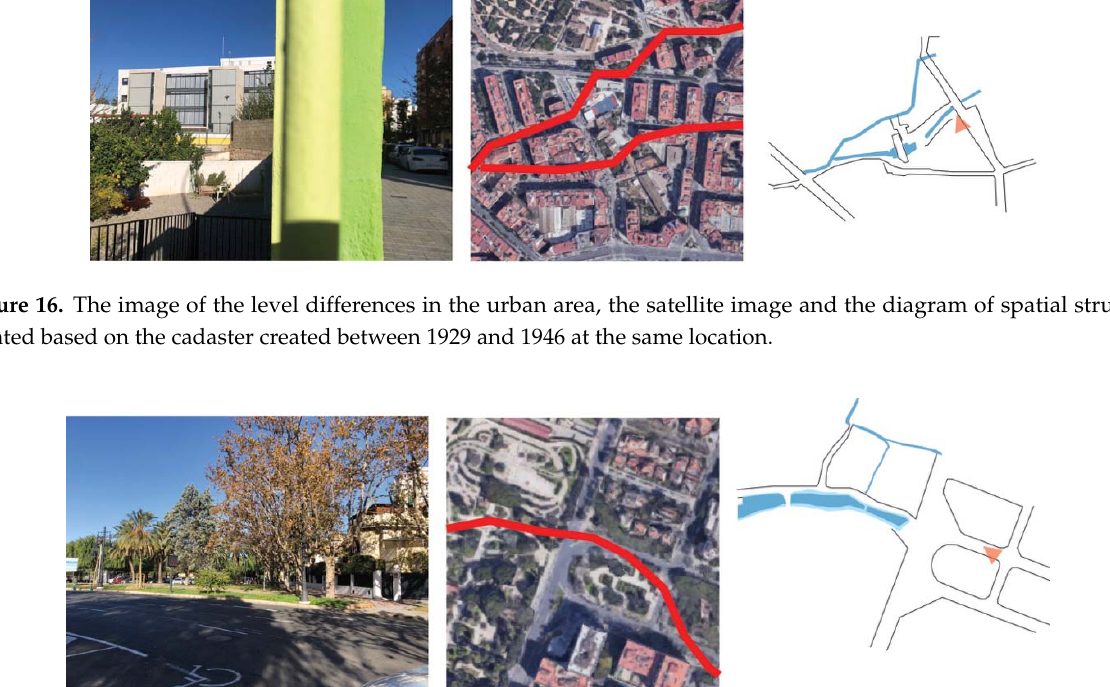
Figure 17. The image of a green area in the urban area, the satellite image and the diagram of spatial structure created based on the cadaster created between 1929 and 1946 at the same location.